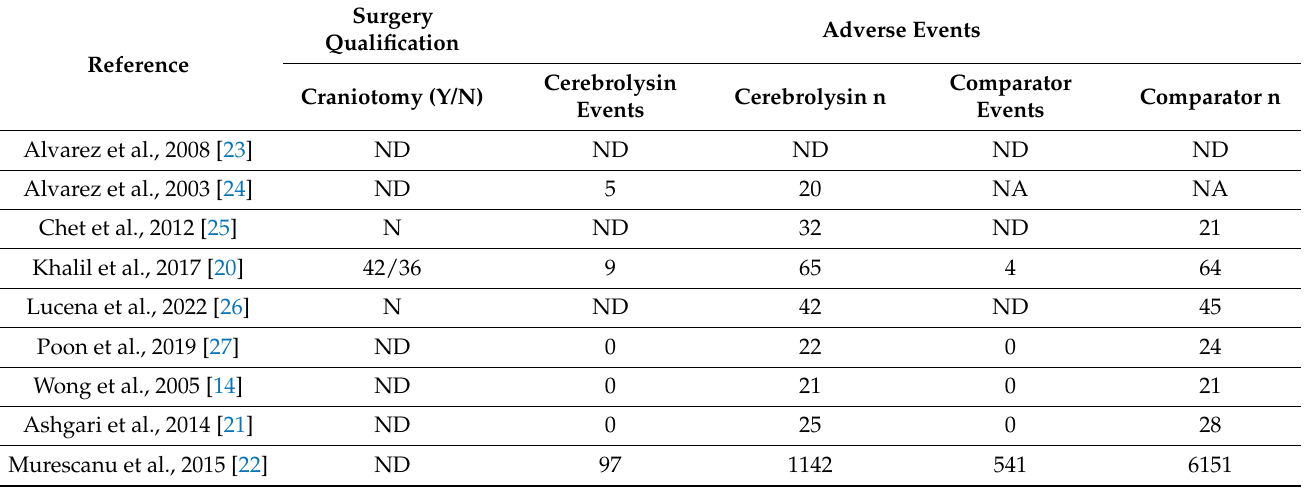
Table 3. Surgery qualifications and adverse events in patients treated with Cerebrolysin and Controls.